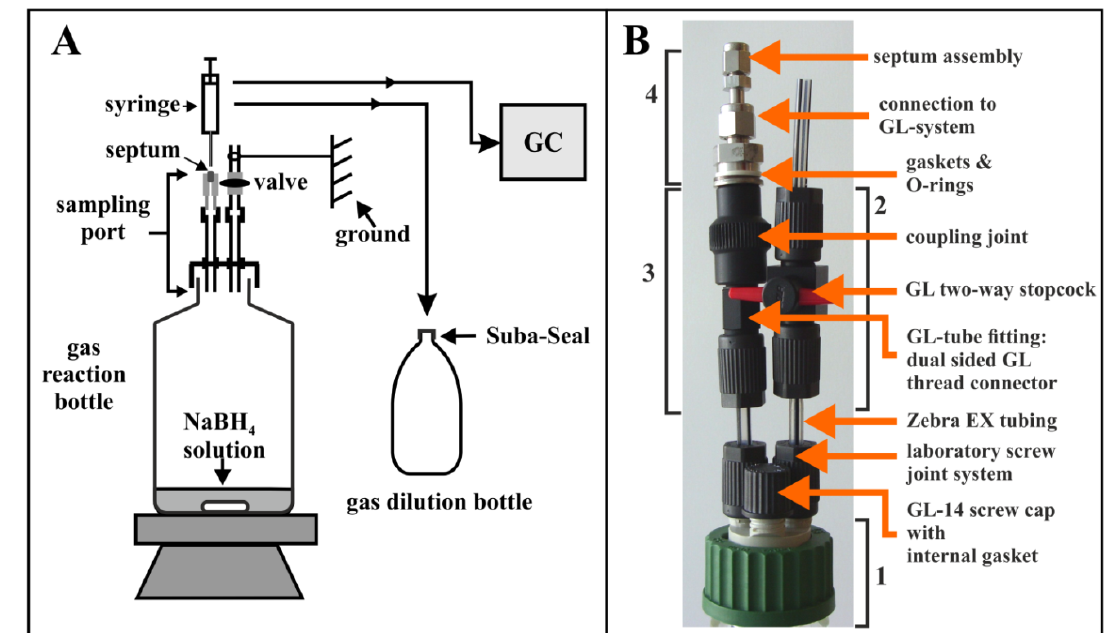
Figure 2. ( A ) Schematic diagram of the gas-tight bottle assembly used for the production of H 2 from defined amounts of NaBH 4 . Gas sampling was performed by using a home-made sampling port assembly containing a gas-tight septum. In this Figure, a “gas dilution bottle” (sealed with a Suba-Seal ® cap) is also shown, which can be used to dilute pressurized gas samples to atmospheric pressure (see Materials and Methods). ( B ) Details of the gas-tight sampling apparatus: (1) GL-45 cap with 3 GL-14 threaded distributors on its head. The unused port is sealed with a GL-14 screw-cap; (2) an assembly with a connection to an external tubing, which can be used for evacuating the bottle and for flushing the bottle with N 2 or other (standard) gas mixtures; (3) the connecting parts between the bottle and (4) the septum assembly containing the gas- tight septum.